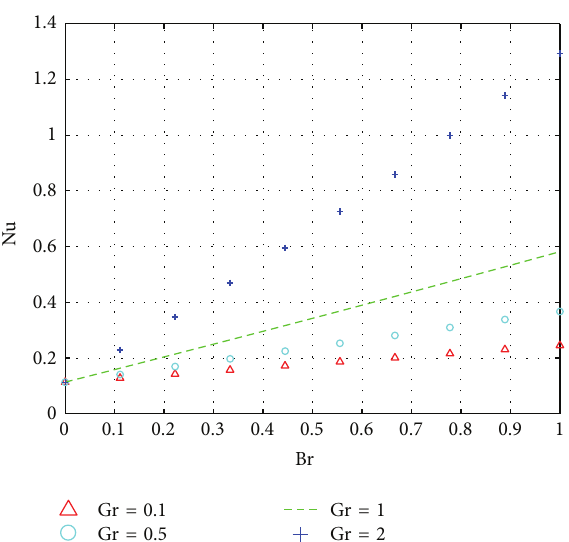
Figure 12: Variation of wall heat transfer with Brinkman number; 𝑡 = 50 .